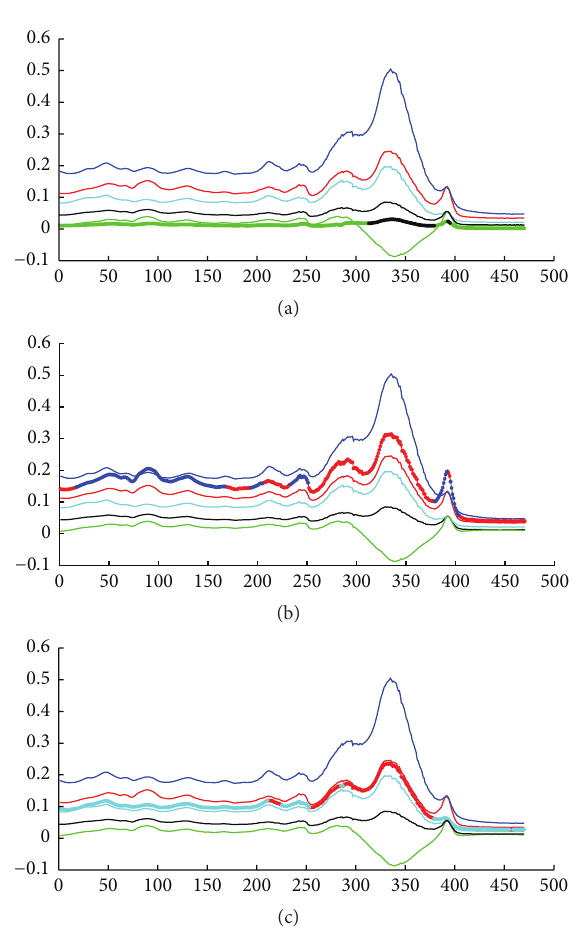
Figure 3: The dynamic behavior of the 6th, 7th and 18th switching time series from top to bottom orderly. The five slender lines represent five centroid series of five clusters,